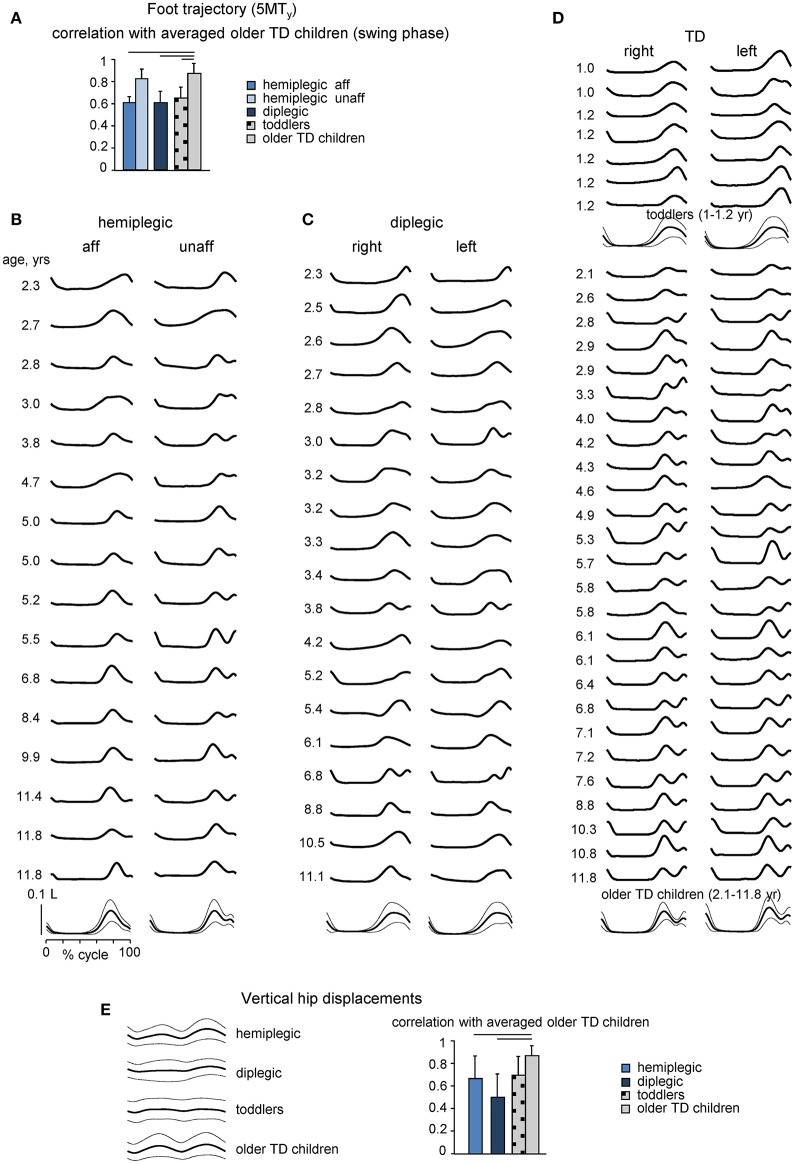
Foot trajectory and vertical hip displacement characteristics. (A), Correlation coefficient (mean + SD) between vertical foot displacements (5MTy, swing phase) in children with CP and TD toddlers and ensemble average in older TD children. (B–D) Averaged across all strides individual foot trajectories (5MTy, ordered according to age from top to bottom) for children with hemiplegia (more affected and least affected sides), diplegia (right and left sides) and TD (right and left sides) children. TD children were divided into two subgroups: 7 toddlers aged 1–1.2 years and 26 older children aged 2.1–11.8 years. The lower curves in B-D illustrate ensemble-averaged (across subjects, ± SD) foot movements. 5MTy is expressed in relative units (normalized by the limb length L). (E) Vertical hip (GTy, averaged for right and left legs) displacements averaged across subjects (mean ± SD, left panel) and correlation coefficients between GTy data in children with CP and TD toddlers and corresponding ensemble averaged GTy in older TD children (right panel). Horizontal lines denote significant differences with older TD children.